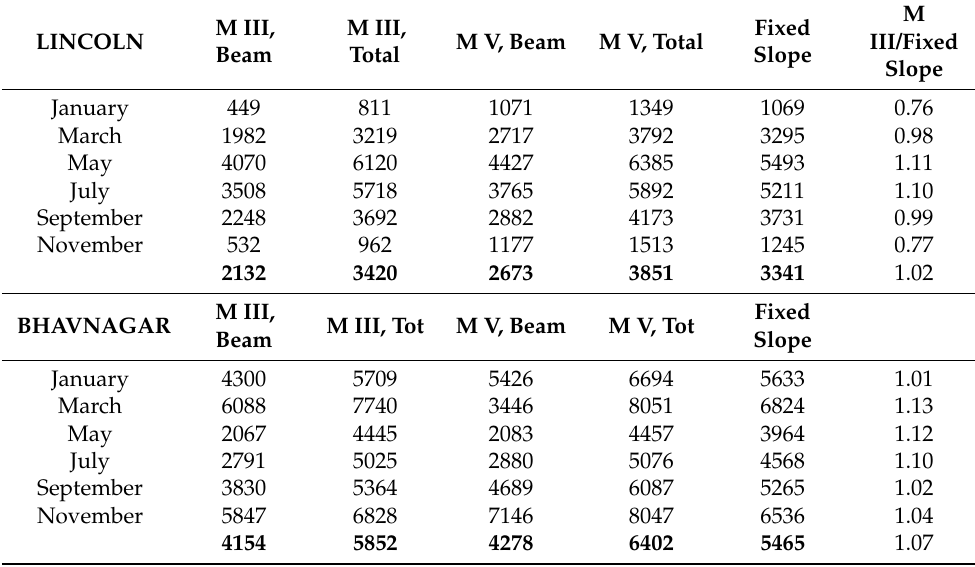
Table 1. Solar radiation received when using mode III, mode V and a south-facing fixed slope for Lincoln and